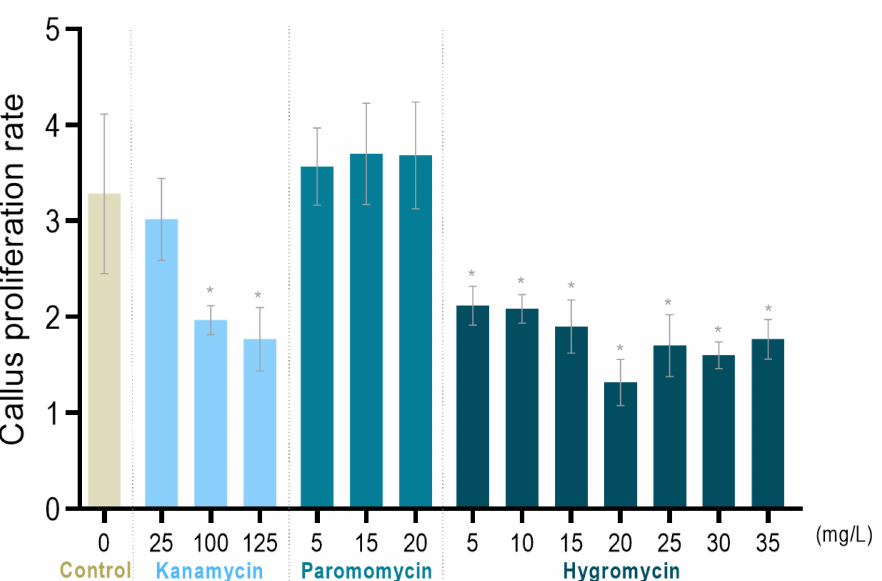
Figure 1. Effect of kanamycin, paromomycin and hygromycin on the proliferation rate of tamarillo callus. Callus proliferation rate is the ratio of fresh weight after thirty days of treatment and the initial one ± SD of at least three biological replicates. * means significant difference ( p -value ≤ 0.0001) between the treatment and the control, according to Dunnett’s